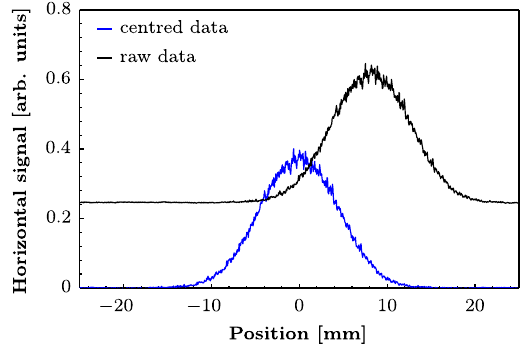
FIG. 22. After removing the contribution of the baseline and the horizontal offset, the profile depicted in blue is obtained. For comparison the horizontal raw data is shown as